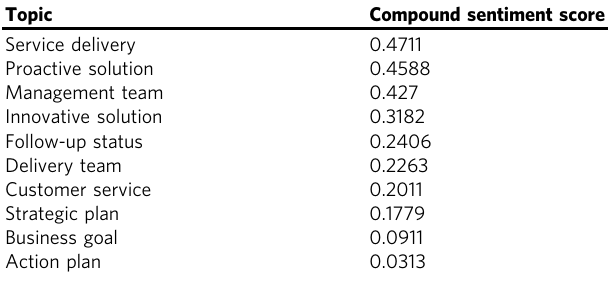
Table 5 Top 10 topics with a weighted positive score.